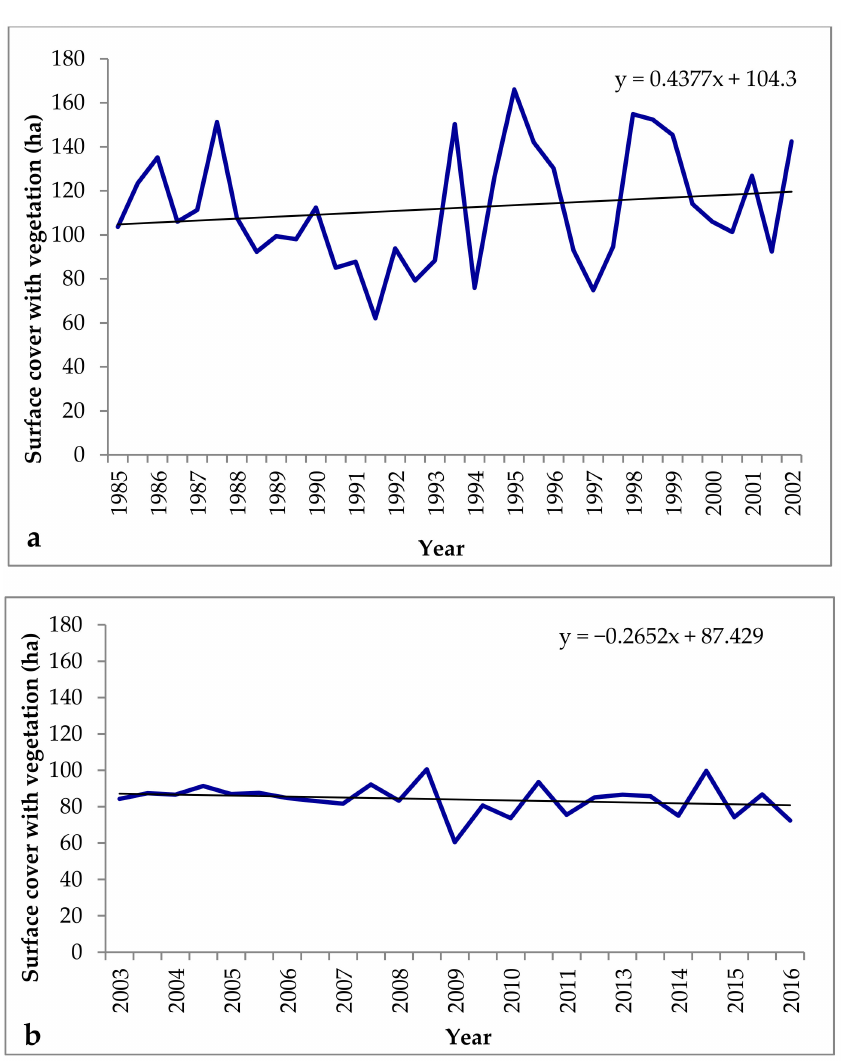
Figure 6. Trends in vegetated areas of the Tilopozo salt meadows 1985–2002 ( a ) and 2003–2016 ( b